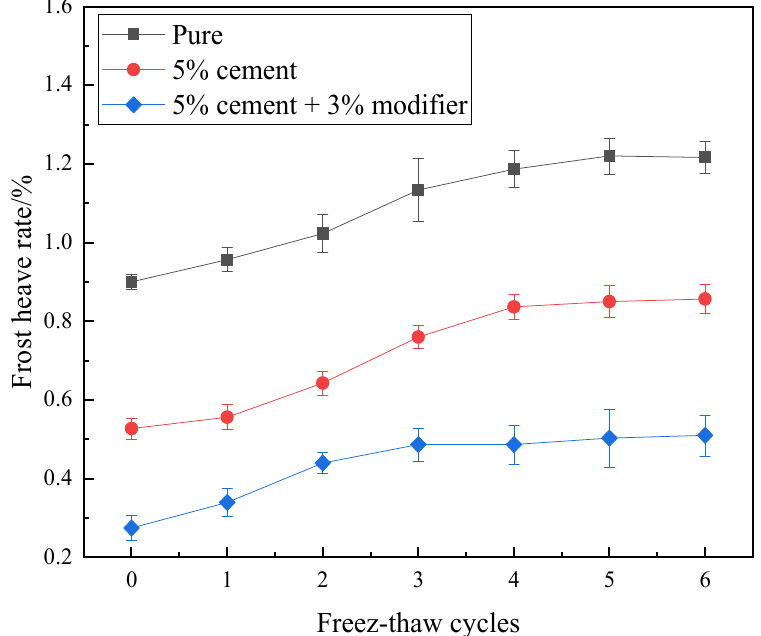
Figure 4. Influence curve of freeze-thaw cycles on frost heave rate.